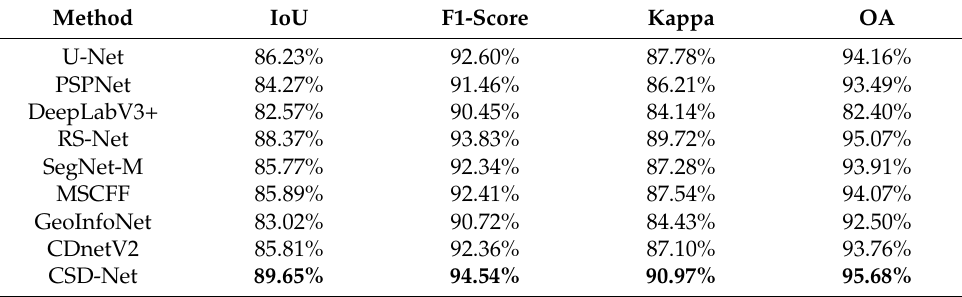
Table 9. The quantitative evaluation comparison on the HRC_WHU dataset.